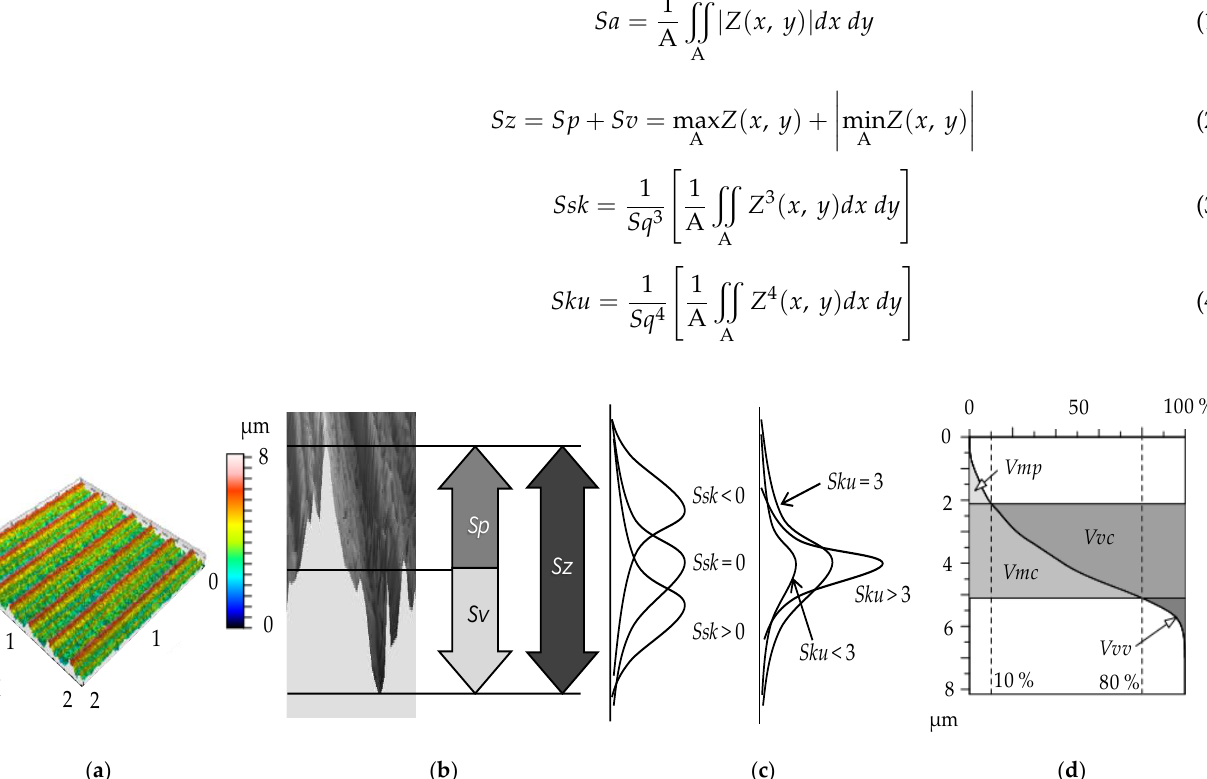
Figure 2. ( a ) The topography of a periodic surface, the determination of the ( b ) maximum peak height ( Sp ), maximum valley depth ( Sv ), maximum height ( Sz ), ( c ) skewness ( Ssk ), kurtosis ( Sku ), ( d ) peak material volume ( Vmp ) and the valley void volume ( Vvv ) parameters.